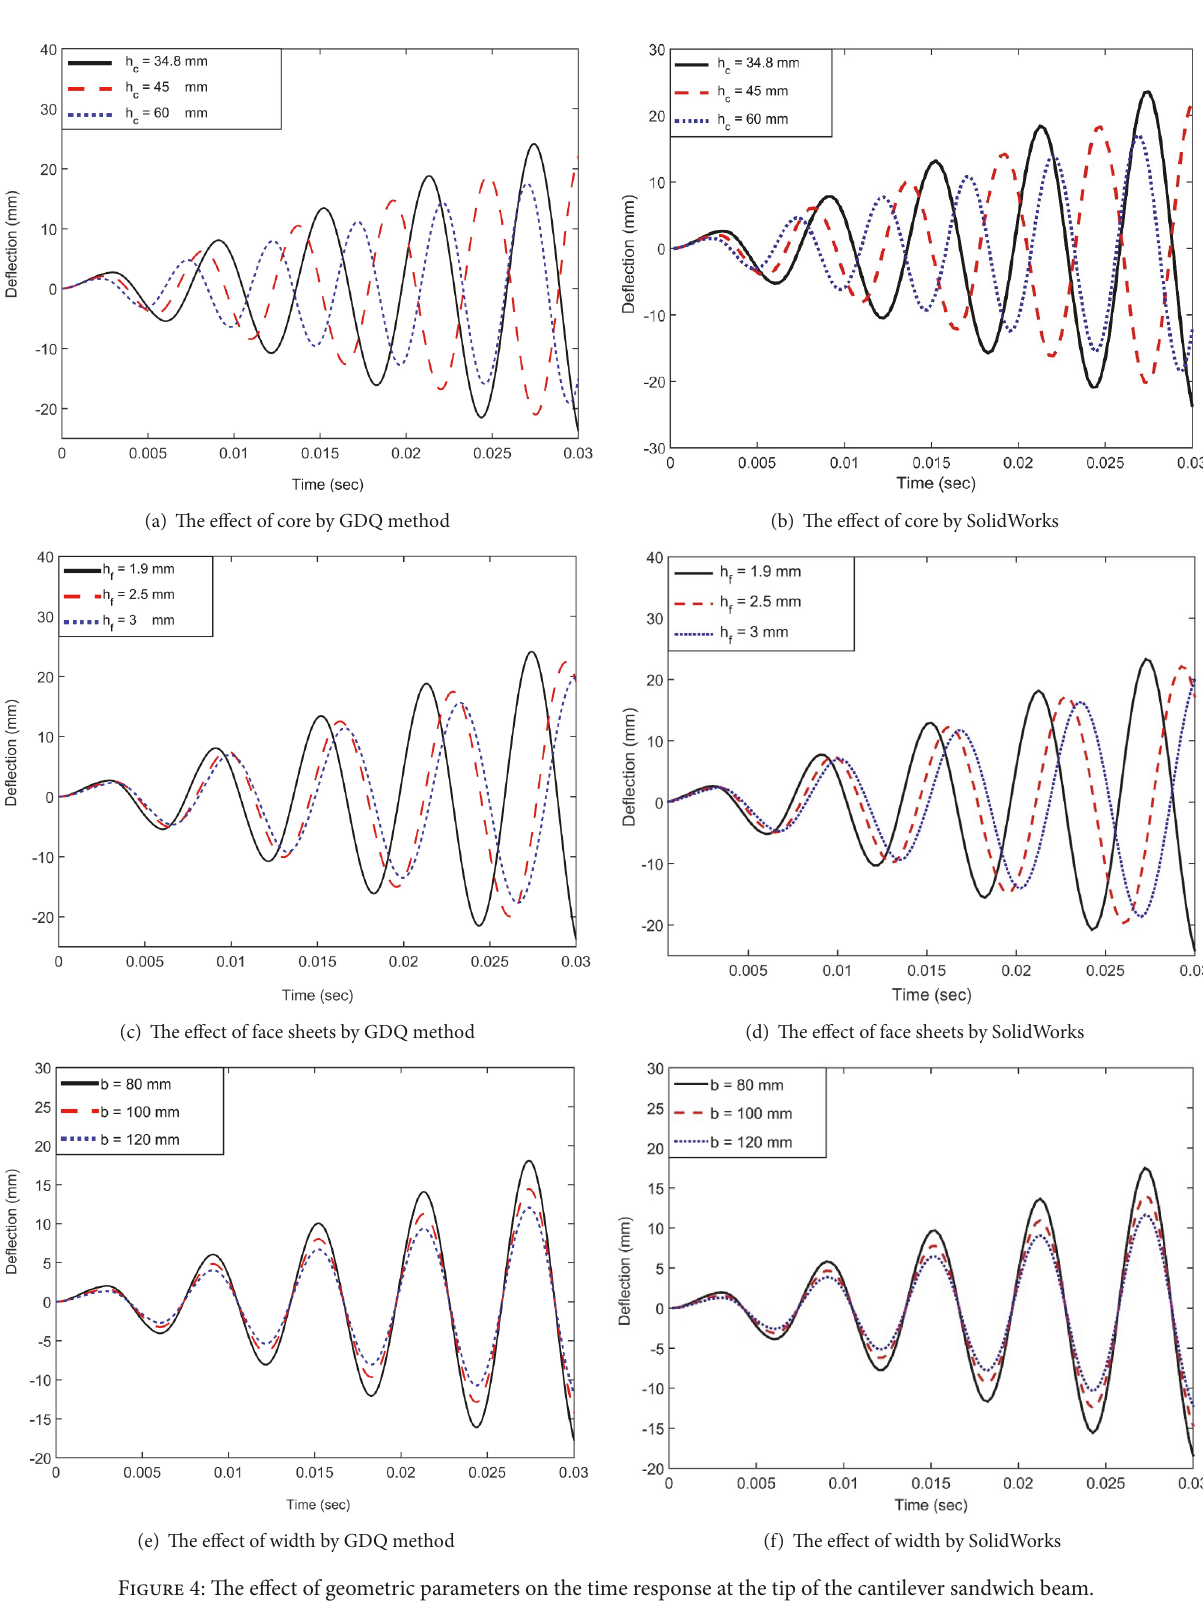
Figure 4: The effect of geometric parameters on the time response at the tip of the cantilever sandwich